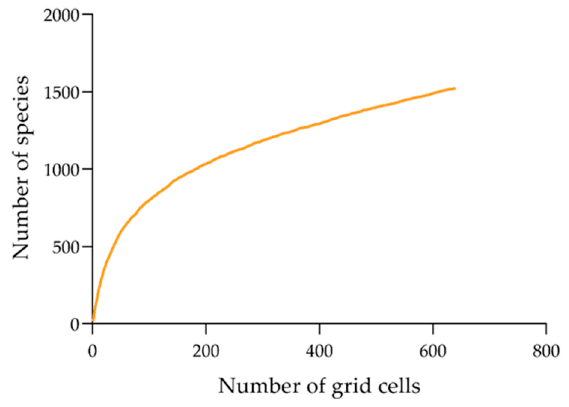
Figure 2. Species bootstrapped accumulation curve.